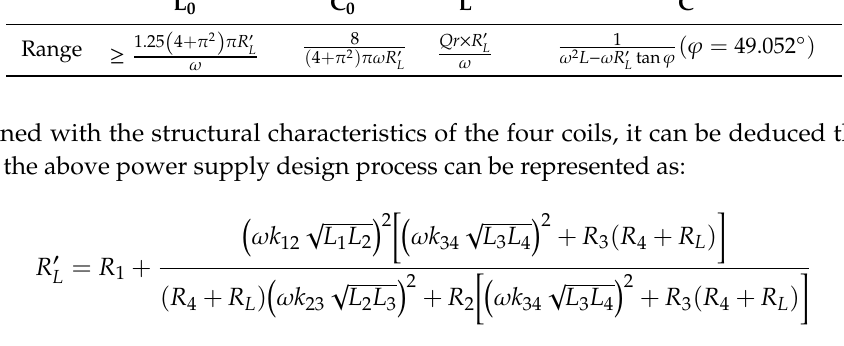
Table 1. Values range of parameters of the class E topological power amplifier. L 0 C 0 L C